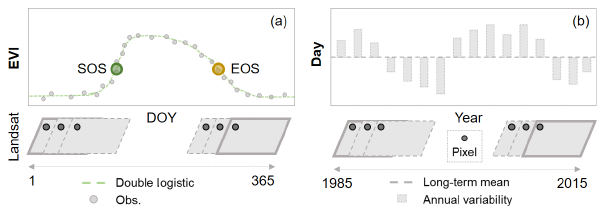
Figure 1. The proposed framework for deriving long-term (1985– 2015) mean vegetation phenology indicators (start of season, SOS, and end of season, EOS) (a) and their annual variabilities (b) .